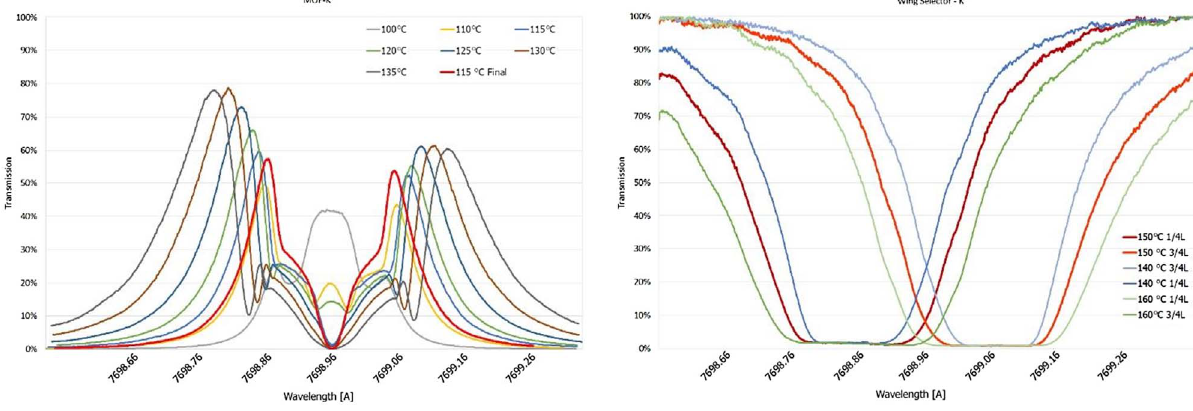
Fig. 6. Left: example of transmission pro fi les of the MOF-K fi lter taken during our several test with different temperatures a magnetic fi eld fi xed at 1400 G. This pro fi les are calibrated in wavelength only. The red curve, which is calibrated both in transmission and wavelength, matches the MOF we are using in its fi nal con fi guration (115 (cid:3) C/1240 G). Right: transmission pro fi les of the Wing Selector (2480 G) at three different temperatures and in the two states of the LCVR (L/4 and 3L/4).